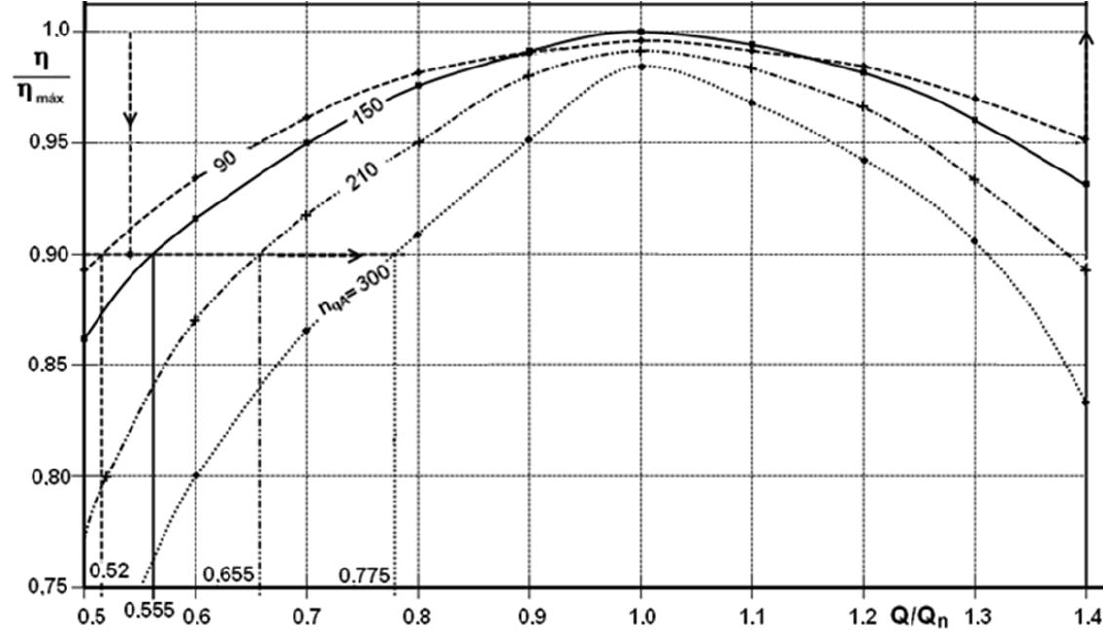
Figure 6. Efficiency curves of Francis runners as a function of normalized flow.